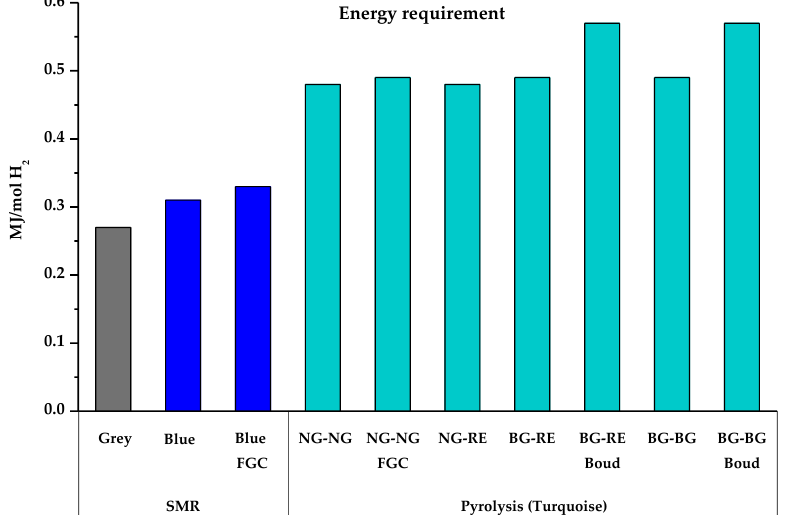
Figure 8. The energy requirement for grey, blue, and turquoise hydrogen production.